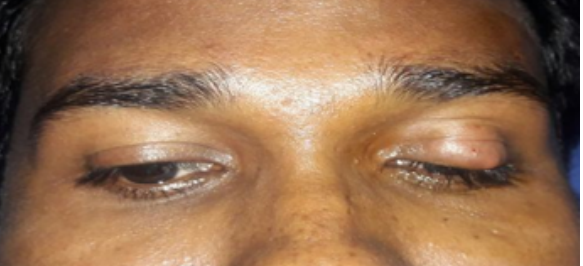
Figure 1: External photograph of the solitary lesion involving the left upper lid